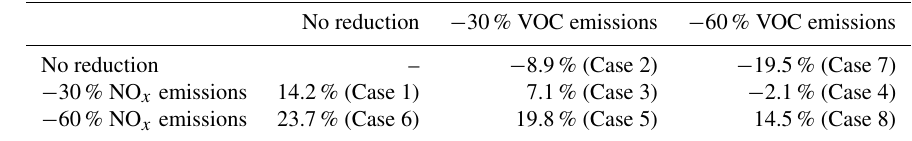
Figure 8. The spatial differences between the simulated SNA concentrations with the bottom-up and top-down NO x emission estimates for January, April, July, and October 2016 (top-down minus bottom-up). Table 3. The changed percentages of ozone concentration based on the sensitivity analysis for April